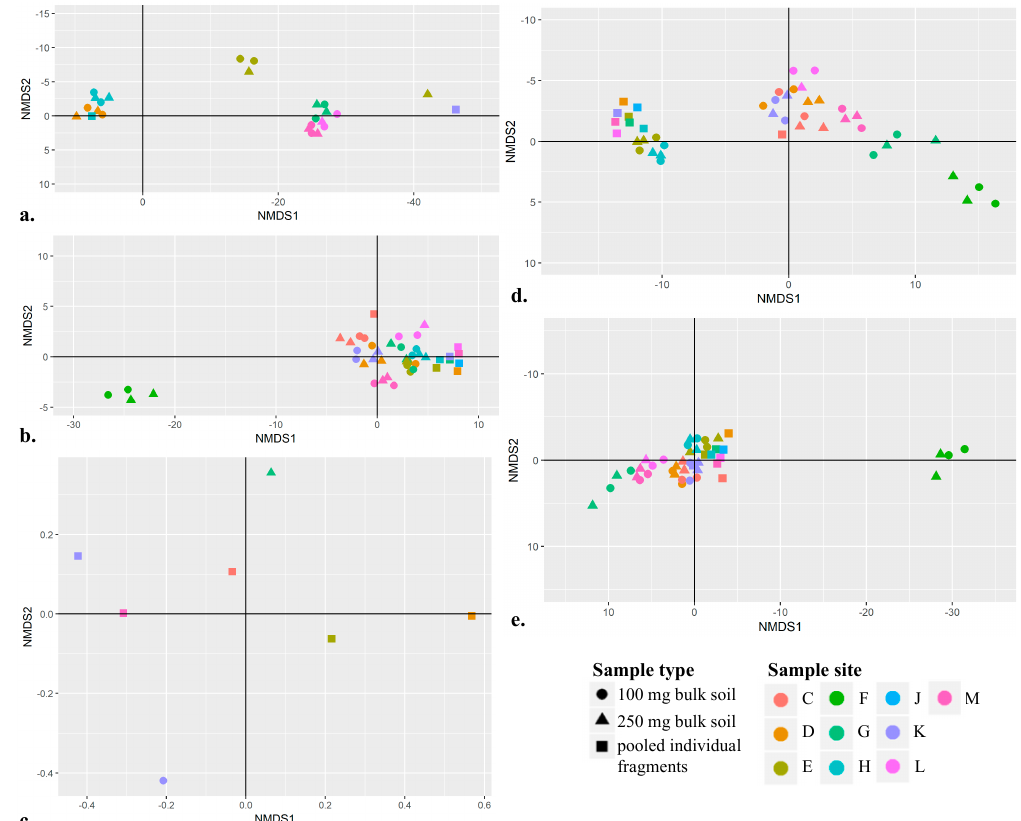
Figure 4. Non-metric multidimensional scaling (NMDS) plots of animal and plant taxa recovered from samples prepared with DNA isolated from 250 mg of bulk soil (triangle), 100 mg of bulk soil (circle), and pooled individual plant and insect fragments (square). The color of the shape denotes sample site ( n = 10). Not all samples are visible ( n = 50) as they either had no data for that marker (e.g., matK ) or had extreme “x-axis limit” values and so were filtered out, or are plotted on top of one another in multidimensional space. Unique target sequences used to generate each NMDS plot are as follows: ( a ) COI entire and COI mini ( n = 283), ( b ) rb cL mini and rbcL entire ( n = 279), ( c ) matK gymno and matK angio ( n = 10), ( d ) rbcL and matK ( n = 289), ( e ) all COI , rbcL and matK ( n = 572).